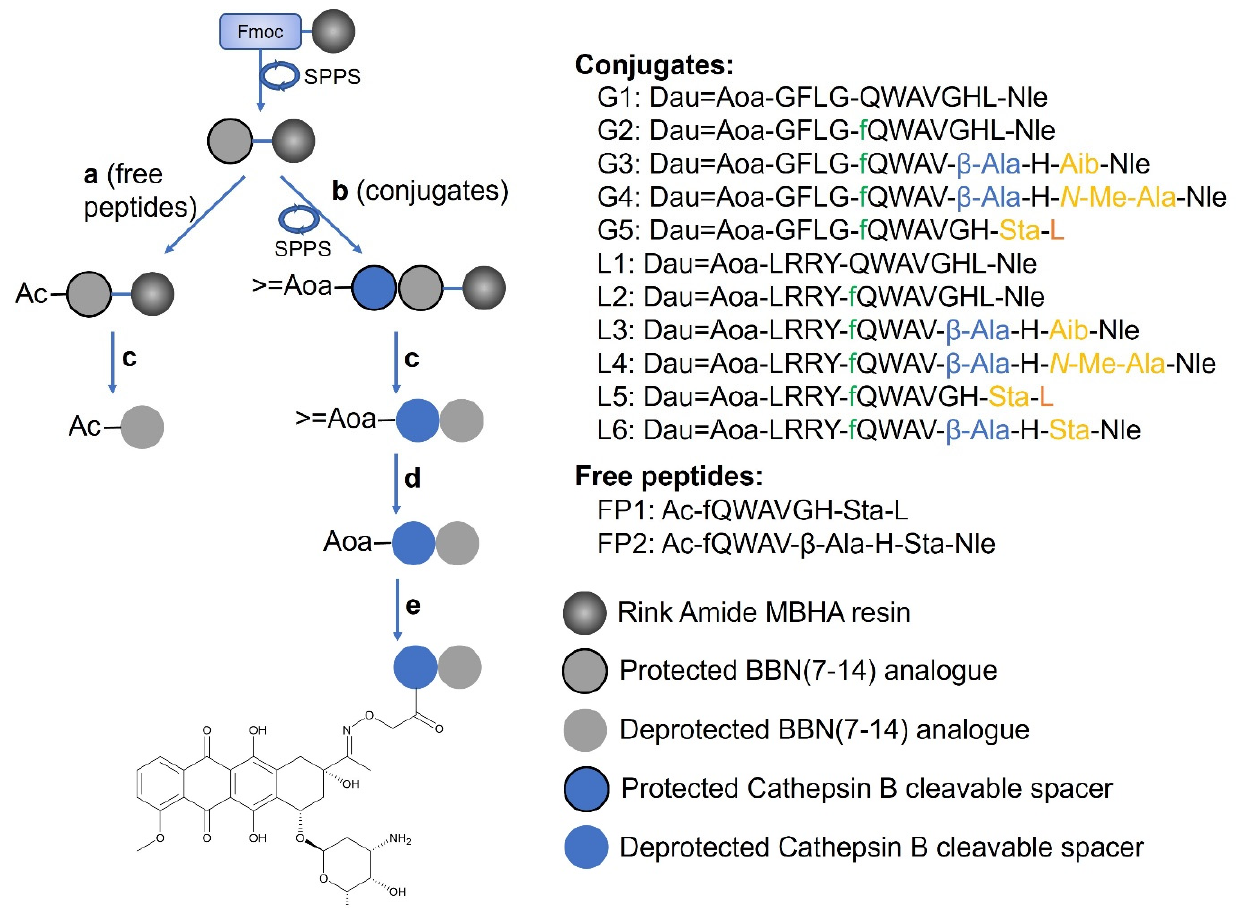
Figure 1. Synthesis of Dau-BBN (7-14) conjugates and BBN (7-14) analogues as free peptides. ( A ) Ac 2 O, DIPEA, DMF (1:1:3 v / v / v %), 30 min, RT. ( B ) (1) SPPS; (2) 3 eq >=Aoa-OH, 3 eq HOBt, 9 eq DIC in DMF, 1 h, RT. ( C ) TFA (95%), 2.5% TIS, 2.5% H 2 O, 2 h ( G1 – G5 , FP1 , FP2 ) or 10 mL TFA, 750 mg crystal phenol, 250 µL EDT, 500 µL thioanisole, 250 µL H 2 O ( L1 – L6 ). ( D ) Methoxyamine (1 M) in 0.1 M NH 4 OAc buffer (pH 5), 1-2 h, RT. ( E ) Dau (1.3 eq) in 0.1 M NH 4 OAc buffer (pH 5), o/n, RT. SPPS: Solid Phase Peptide Synthesis; Ac: acetyl; >=Aoa: isopropylidene aminooxyacetyl; Aoa: aminooxyacetyl; Aib: 2-aminoisobutyric acid; Sta: statine.